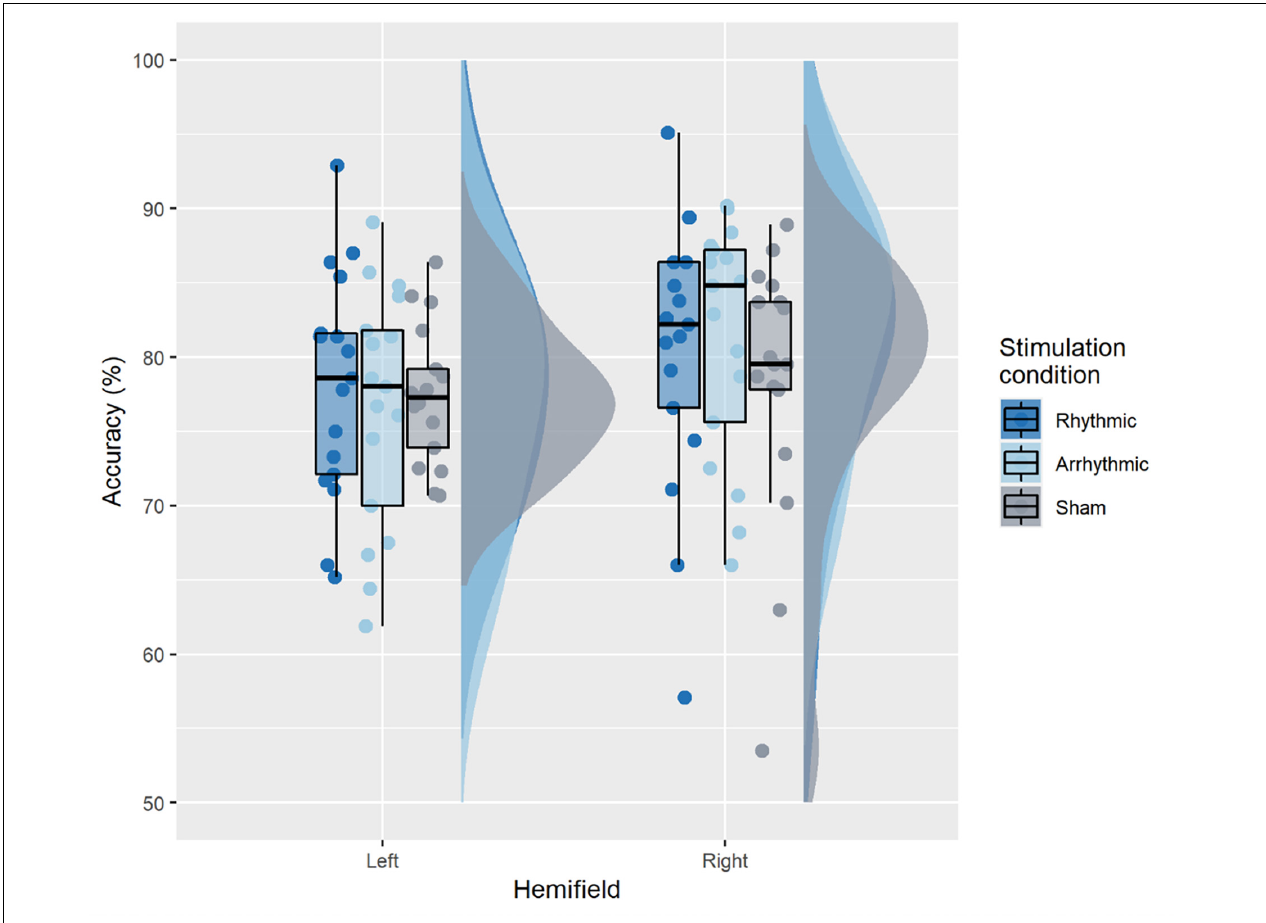
FIGURE 3 | Accuracy across conditions. The boxplots show a representation of the median and the first and third quartiles of the average accuracy per TMS condition and target location. The whiskers of the boxplot can take a maximal value up to 1.5*interquartile range. The boxplots are superimposed with individual data points, while the clouds represent the probability distribution of the